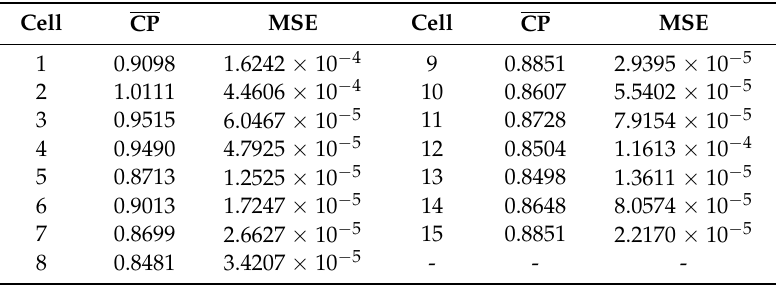
Table 1. Mean of CPs obtained using the proposed approach (CP) and the mean square error (MSE) between CPs extracted using ImageJ-Supervised Tracking and our automatic tracking proposal. Adenosine triphosphate (ATP) stimulus experiment.